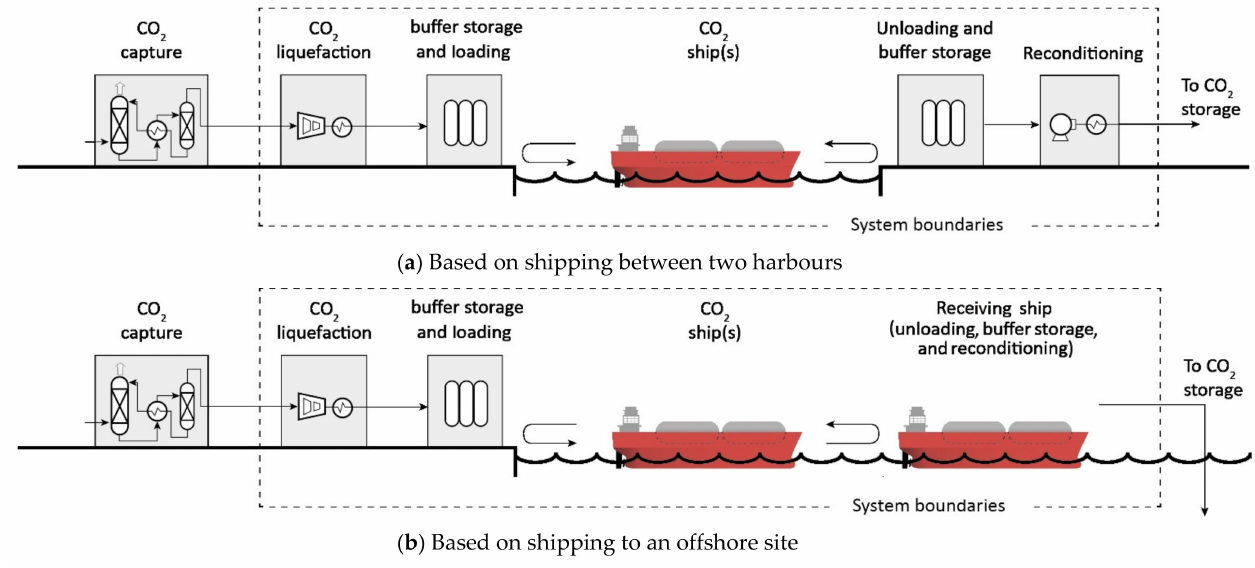
Figure 1. Illustration of the steps of a ship-based CCS chain and the system boundaries considered in the present